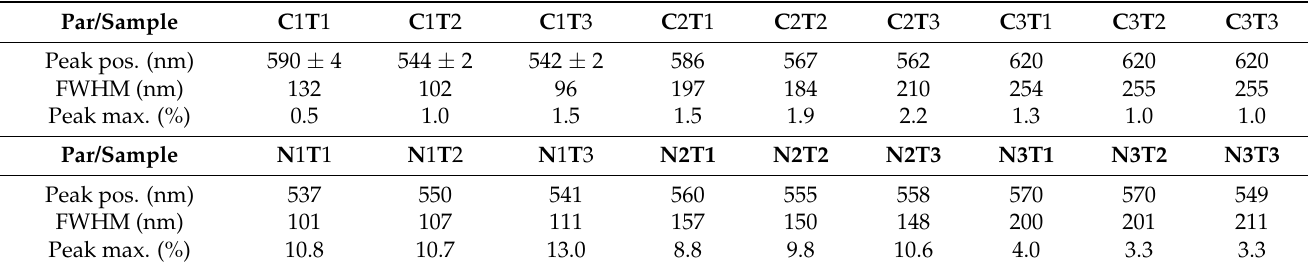
Table 3. Parameters of the SPR contribution to the absorptance spectra. The peak position, its full width at half maximum (FWHM) and its maximal intensity (Peak max.) are shown. The unit of the maximum of the peak is percentage of the